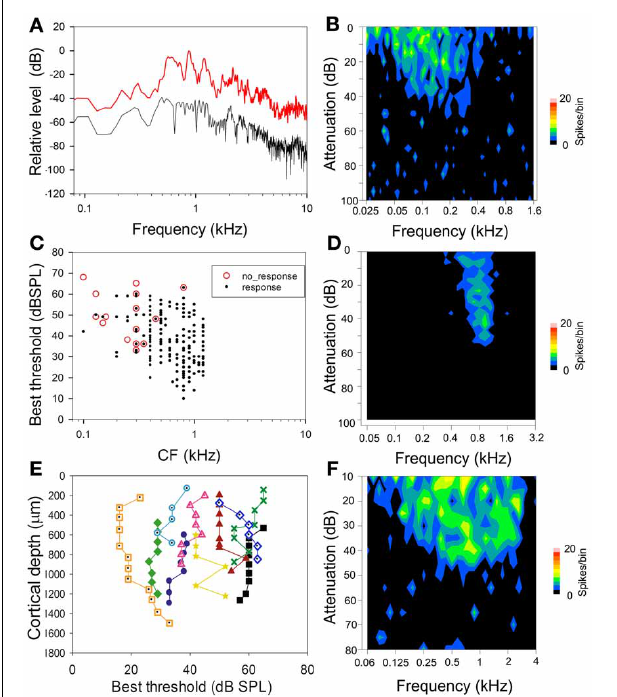
FIGURE 1 | (A) High resolution spectral analysis of the chutter based on the mean of 50ms segments of the three main phrases in the call. The graphs show the maximum (red) and minimum (black) sound levels for each frequency plotted relative to the loudest sound level in the call. Most of the energy is contained within the frequency range 0.5–1.5kHz and this is the range of CFs for most of the units selected in this study. (B) Frequency response area (FRA) of a unit with a CF of 0.13kHz which did not respond to the chutter call. (C) Distribution of CFs and best thresholds of the units recorded in this study. The red circles indicate units which did not respond to the chutter call. There is a broad range of thresholds for units at each CF. The unresponsive units have a CF of below 0.4kHz or a high threshold. (D) Narrowly tuned FRA from a unit with a CF of 0.8kHz that responded reliably to the chutter call. (E) Line plots of changes in the best threshold of units in 10 separate orthogonal tracks. Overall there is a range of about 50dB in the best thresholds shown, but the thresholds don’t vary by more than 20dB in any one track. (F) Broadly tuned FRA from a unit with a CF of 0.7kHz that showed a strong response to the chutter and illustrates the fact that CF, best threshold and width of tuning may all be factors in determining to what degree a unit responds to the chutter